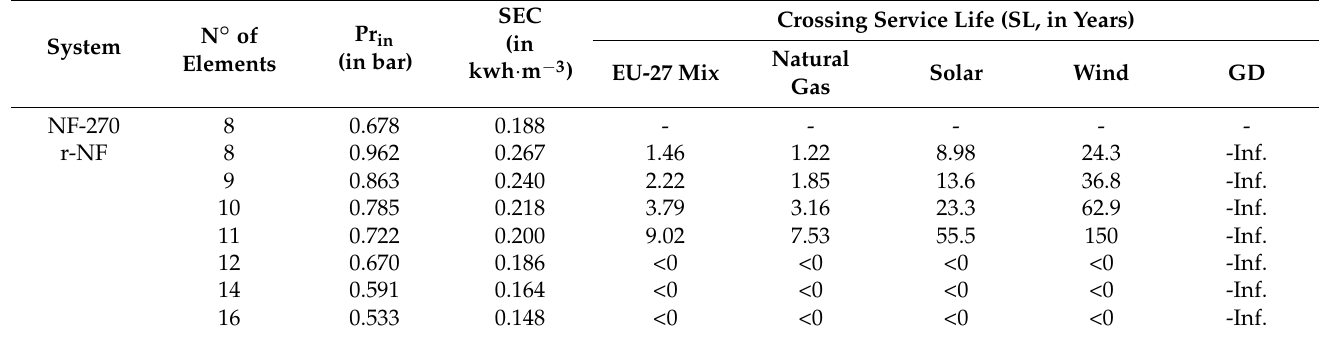
Table 1. Process Pr in , SEC and crossing service life for equivalent carbon footprint by energy